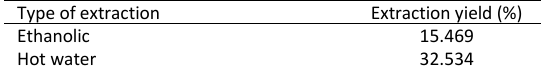
Table 1: Percentage of extraction